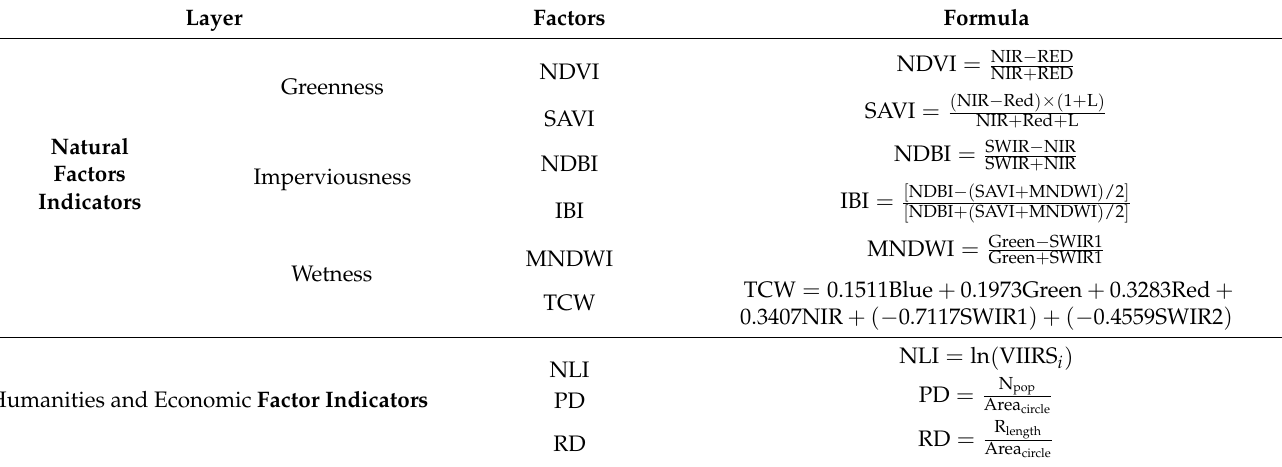
Table 2. Factors and their calculation